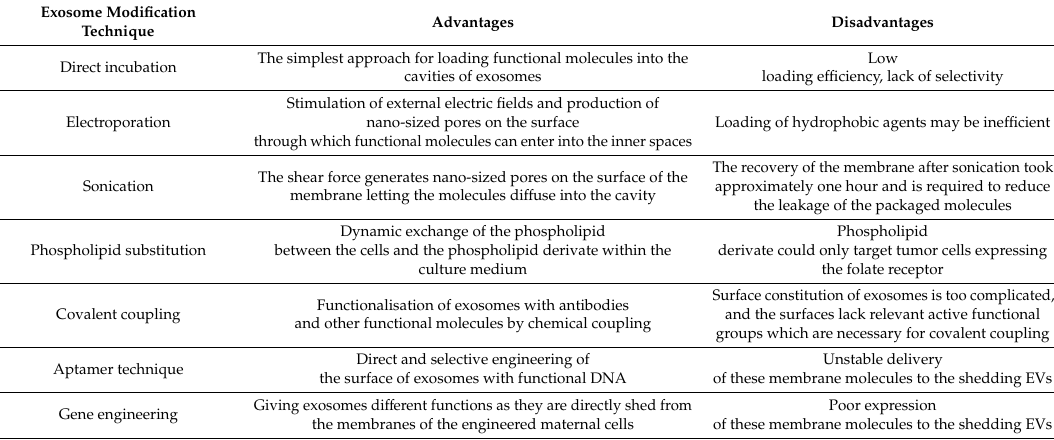
Table 1. Modification strategies of exosomes for applications in contrast media and radionuclide composition as well as theranostic